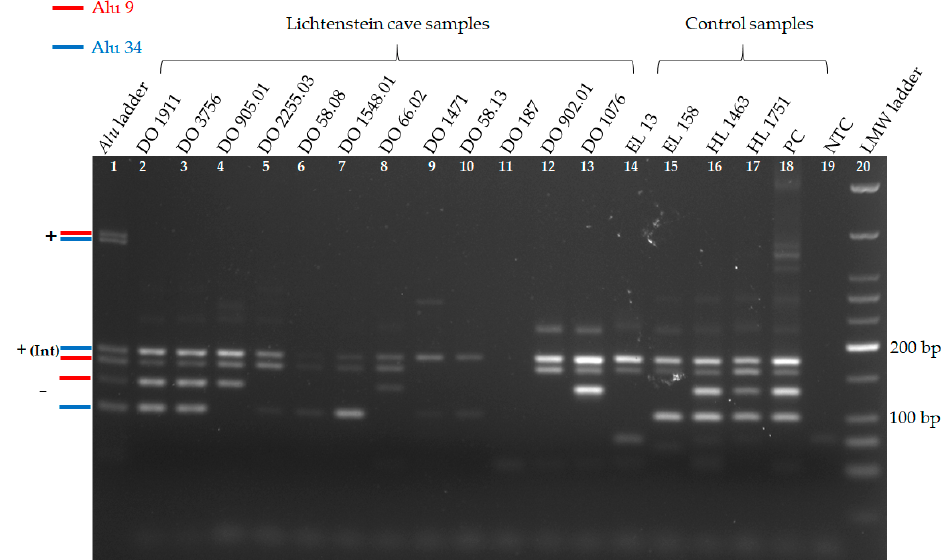
Figure 2. Gel electrophoresis of Alu duplex 1, containing Alu 9 and 34 in twelve Lichtenstein cave samples and five control samples. Apart from the positive control samples, fully informative results of Lichtenstein cave samples can be seen in lanes 2–8 and 12–13. The most degraded samples (lane 9–11) show only partial results. Amplification results of Alu 34 are visible in 11 out of 12 Lichtenstein cave samples (lane 2–10 and 12–13). On the left in red and blue is the expected length of each possible amplicon illustrated by the Alu ladder. The insertion (+) of an Alu element is shown by the internal (Int) fragment. Some samples show weak unspecific bands longer than 200 bp. On the right is the modern DNA positive control sample (PC), the negative control sample (NTC), and the LMW ladder. The gel ran at 100 V for 90 min and had a UV light exposure time of 1.08